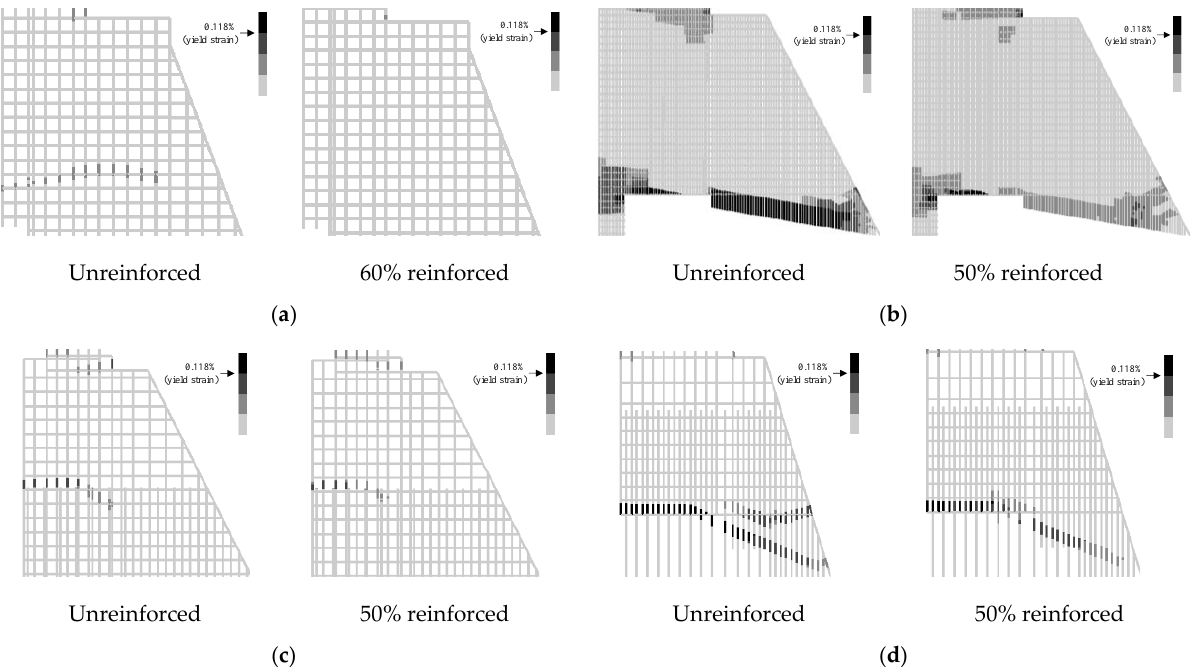
Figure 34. Strain distribution of existing reinforcing bars at peak displacement in wave B: ( a ) TYPE-A; ( b ) TYPE-B; ( c ) TYPE-C; ( d ) TYPE-D.